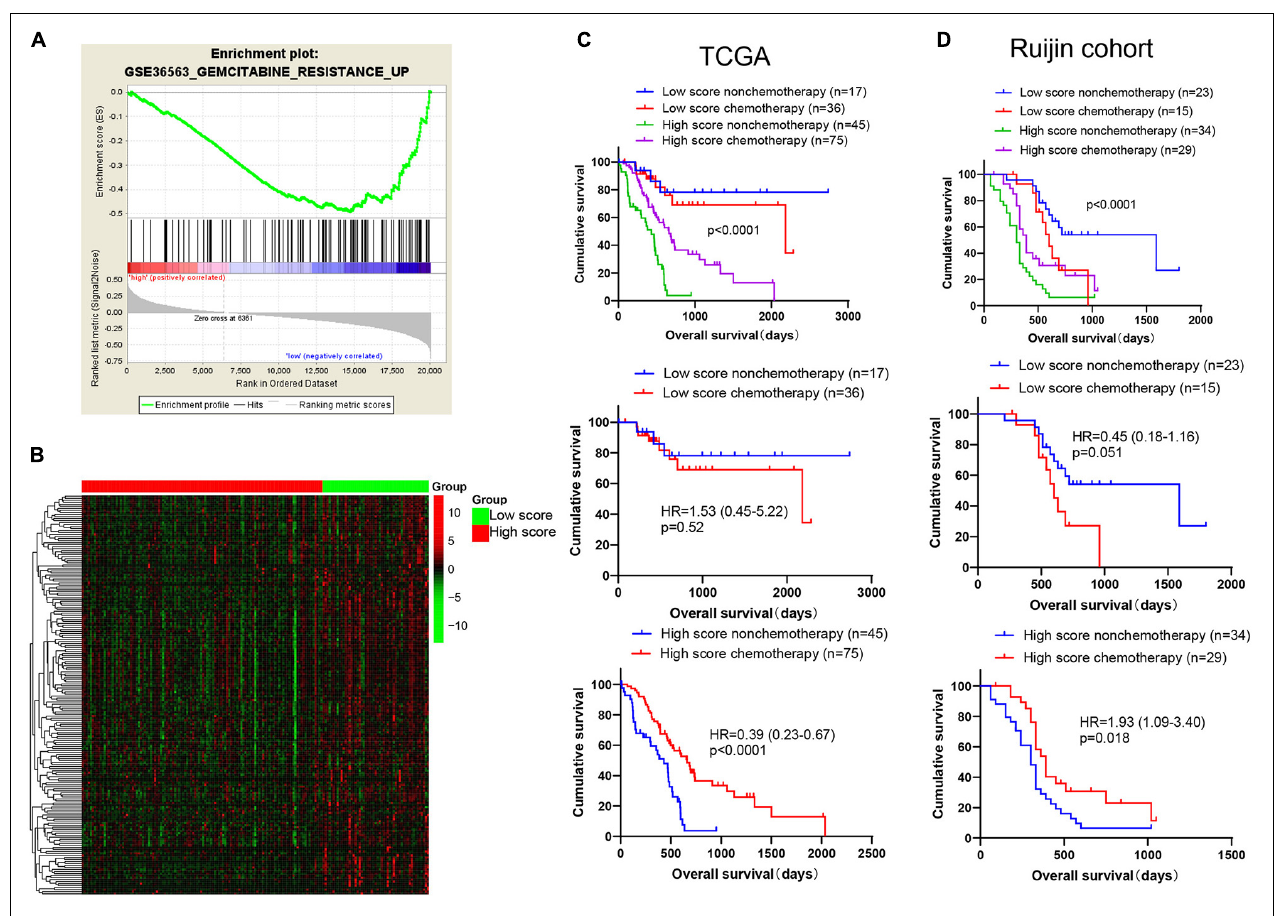
FIGURE 7 | Benefit of gemcitabine-based chemotherapy among patients in high and low score groups. (A) The gemcitabine resistance related gene set was significantly enriched in the low score group of TCGA cohort by GSEA analysis. The green curve represents enrichment score (ES). The highest point was used to represent ES value in gemcitabine resistance pathway. The ES value indicates the correlation between gene and gemcitabine resistance pathway. The black bar codes represent genes in gemcitabine resistance pathway and these genes were ordered according to their expression levels. The left end or right end genes are leading edge subset strongly contributed to ES value. The bottom numbers represent the order of expression levels in the genome from highest to lowest. (B) The 198 gemcitabine resistance-related genes were significantly attenuated in high score group of TCGA cohort ( p < 0.05). Patients from the (C) TCGA database ( n = 173) and (D) Ruijin cohort ( n = 101) are divided into four groups (TCGA, Low score non-chemotherapy, n = 17, Low score chemotherapy, n = 36, high score non-chemotherapy, n = 45, high score chemotherapy, n = 75; Ruijin, Low score non-chemotherapy, n = 23, Low score chemotherapy, n = 15, high